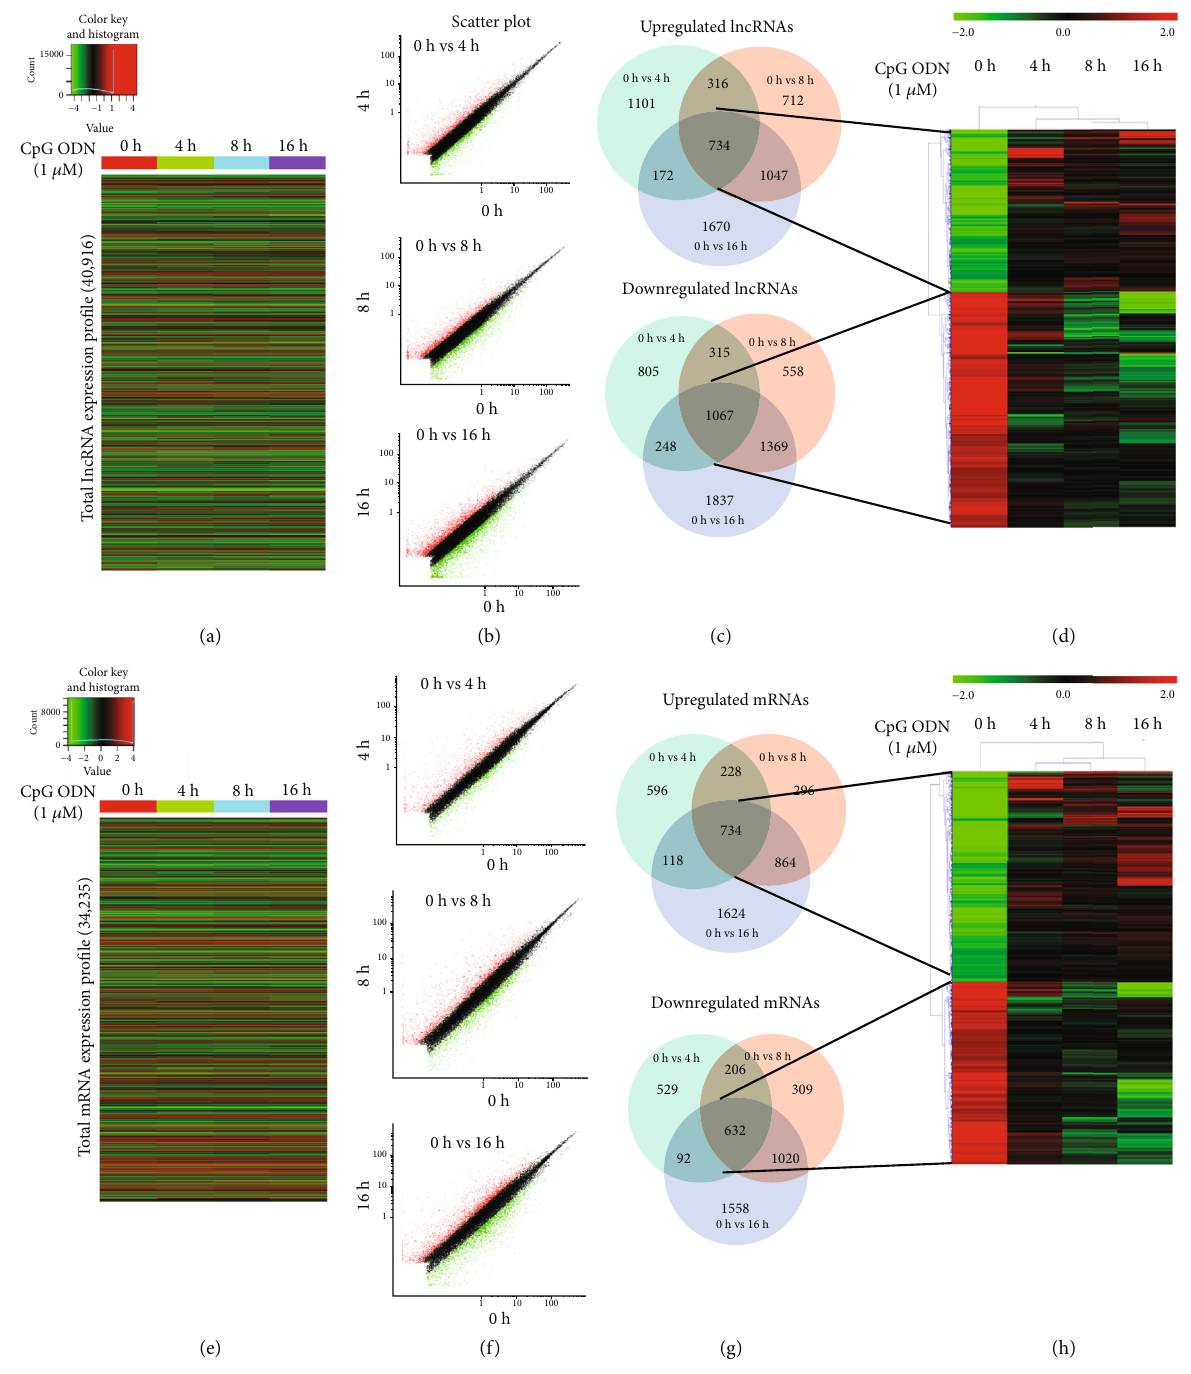
Figure 2: Changed expression pro fi les of lncRNAs and mRNAs during CpG ODN-induced macrophage activation. (a) The heat map of all lncRNA expression at di ff erent time points during CpG ODN-induced macrophage activation from microarray data. (b) Scatter plots showing di ff erentially expressed lncRNAs between macrophages with the stimulation with CpG ODN at 0h and activated macrophages at di ff erent time points (4 h, 8h, and 16h). (c) Often di ff erentially expressed lncRNAs between macrophages with the stimulation with CpG ODN at 0h and activated macrophages at di ff erent time points (4 h, 8 h, and 16h). (d) Hierarchical clustering showing often upregulated and downregulated lncRNAs among the four groups (macrophages stimulated for 0h, 4 h, 8 h, and 16 h). (e) The heat map of all mRNA expression at di ff erent time points during CpG ODN-induced macrophage activation from microarray data. (f) Scatter plots showing di ff erentially expressed mRNAs between macrophages with the stimulation with CpG ODN at 0 h and activated macrophages at di ff erent time points (4 h, 8h, and 16h). (g) Often di ff erentially expressed mRNAs between macrophages with the stimulation with CpG ODN at 0h and activated macrophages at di ff erent time points (4 h, 8h, and 16h). (h) Hierarchical clustering showing often up- and downregulated mRNAs among the four groups (macrophages stimulated for 0 h, 4 h, 8h, and